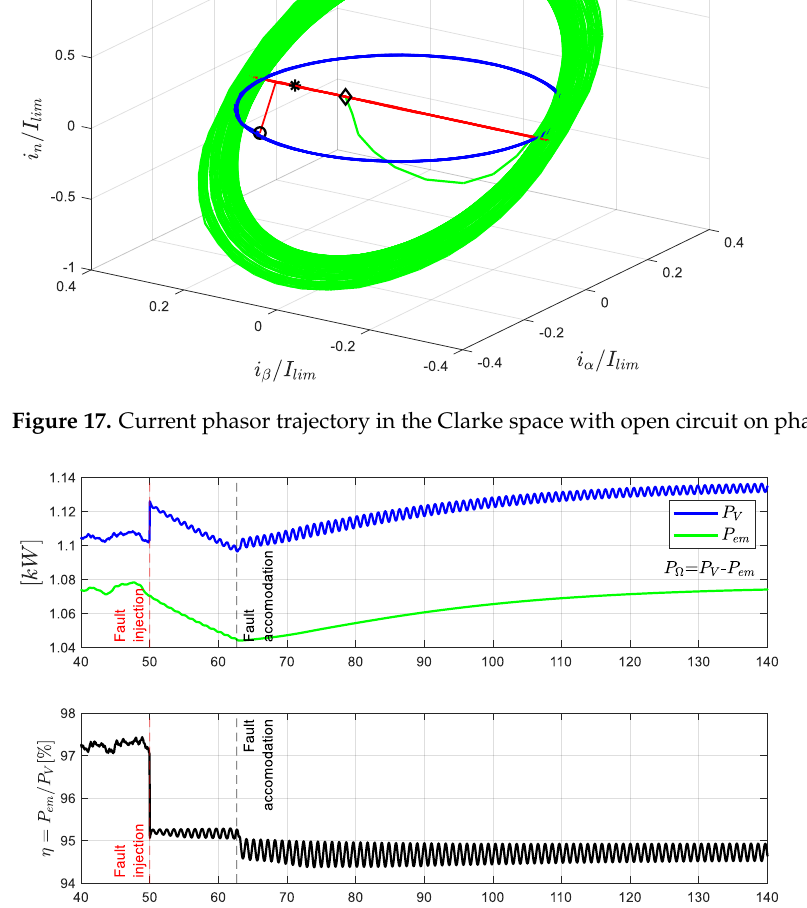
Figure 18. Power signals and power efficiency with open circuit on phase a at t = 50 msec.